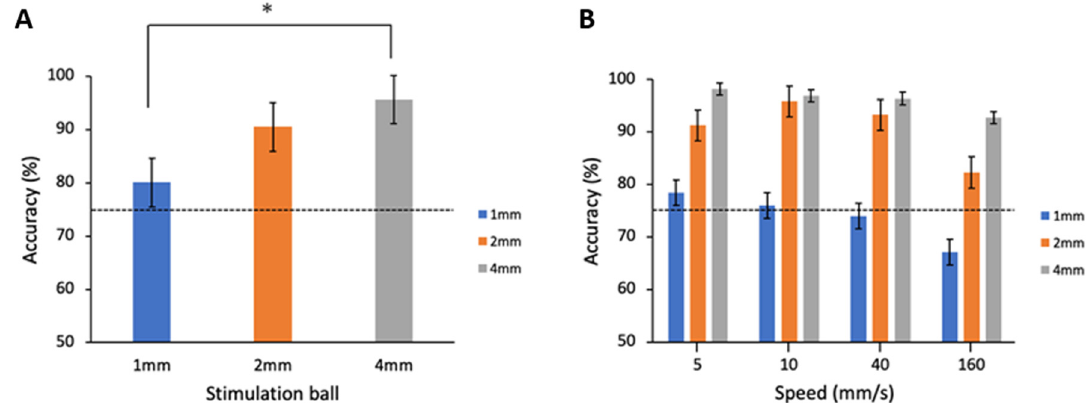
Figure 4. Performance results of 1, 2, and 4 mm sine ‐ wave grating ball in terms of accuracy of orientation identification in different stimulus orientations and speeds. ( A ) Comparison of the accuracy of 1, 2, and 4 mm sine ‐ wave grating ball stimulation revealed a significant difference ( p = 0.019). The accuracy of 1, 2, and 4 mm sine ‐ wave grating ball stimulation is 77.67 ± 5.14%, 89.88 ± 1.99%, and 95.93 ± 1.45%, respectively. The error bars indicate SEM. ( B ) Comparison of the accuracy for speeds of 5, 10, 40, and 160 mm/s of 1, 2, and 4 mm sine ‐ wave grating ball stimulation revealed that tactile accuracy differed across 5 mm/s and 160 mm/s ( p < 0.001, repeated measure ANOVA test). The accuracy for speeds of 5, 10, 40, and 160 mm/s are 96.87 ± 4.02%, 97.57 ± 3.30%, 94.79 ± 5.06%, and 73.26 ± 12.24%, respectively, * indicates p < 0.05 in post hoc comparisons.